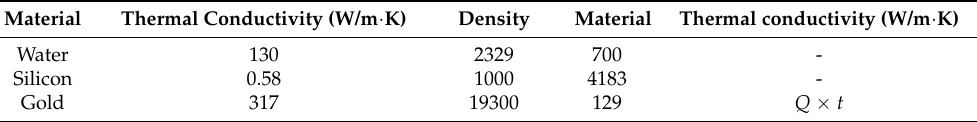
Figure A4. Heat transfer characteristics. Table A1. COMSOL heat transfer parameters.